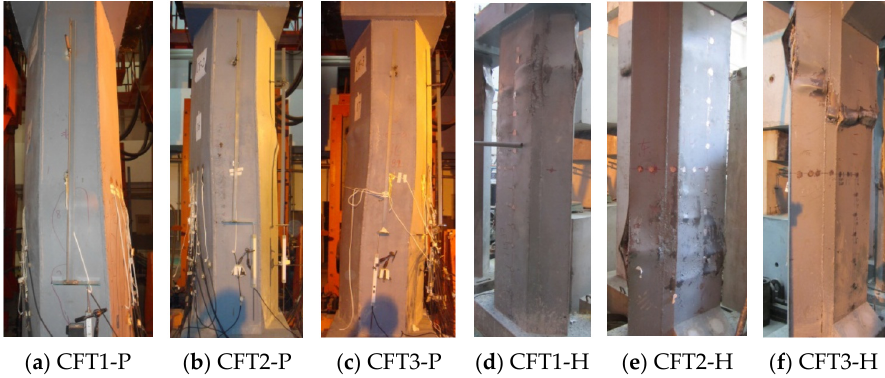
Figure 7. Failure patterns of specimens.